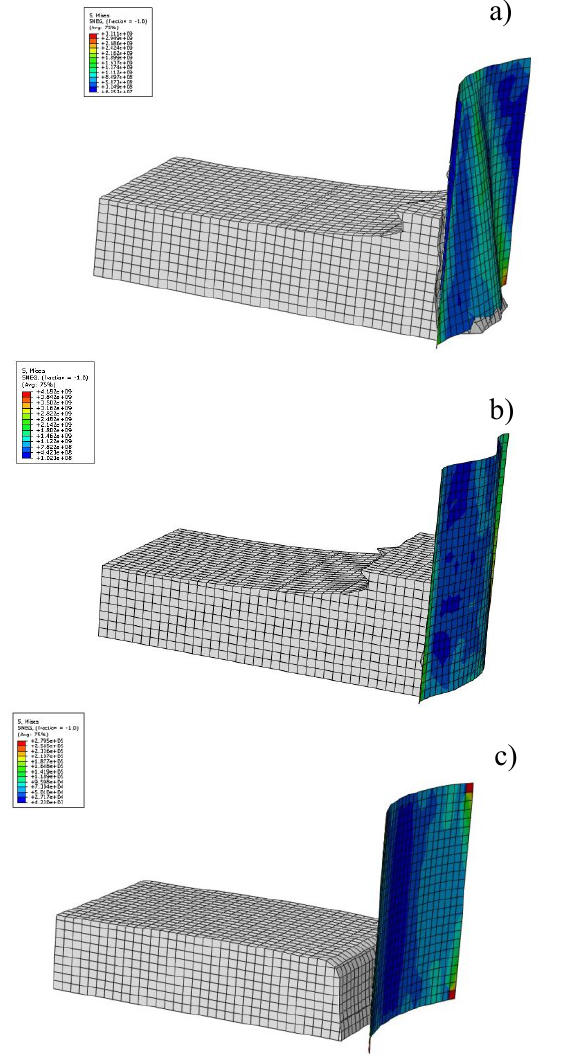
Fig. 3. FEM model of anti-flood board: a) thick 1,5 mm, b) thick 2 mm, c) thick 3